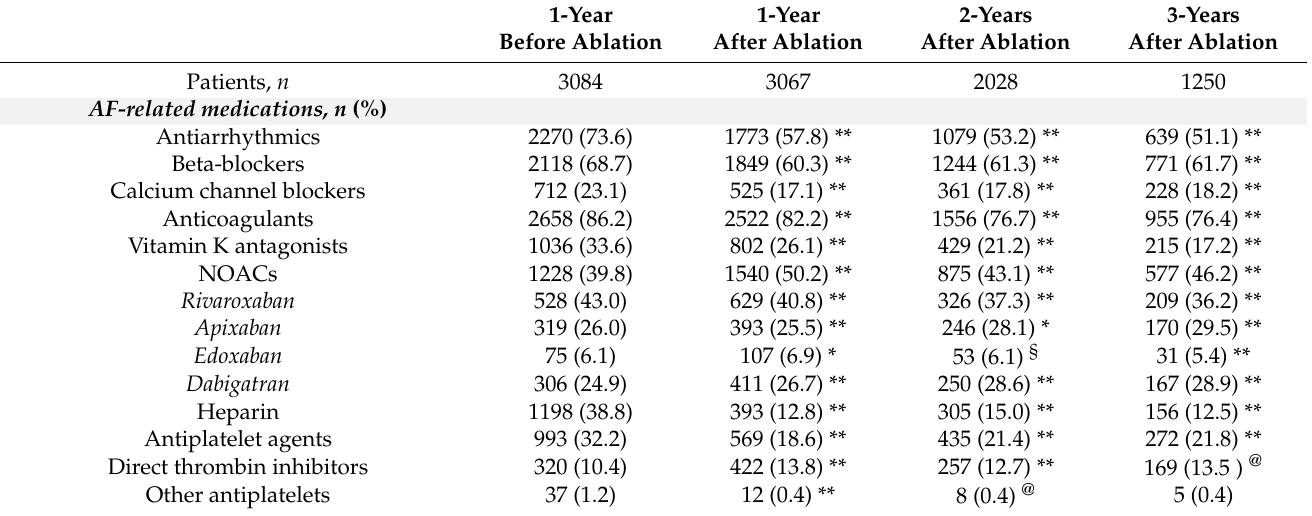
Table 2. Use of AF-related medications and CV hospitalizations in included patients at baseline and after catheter